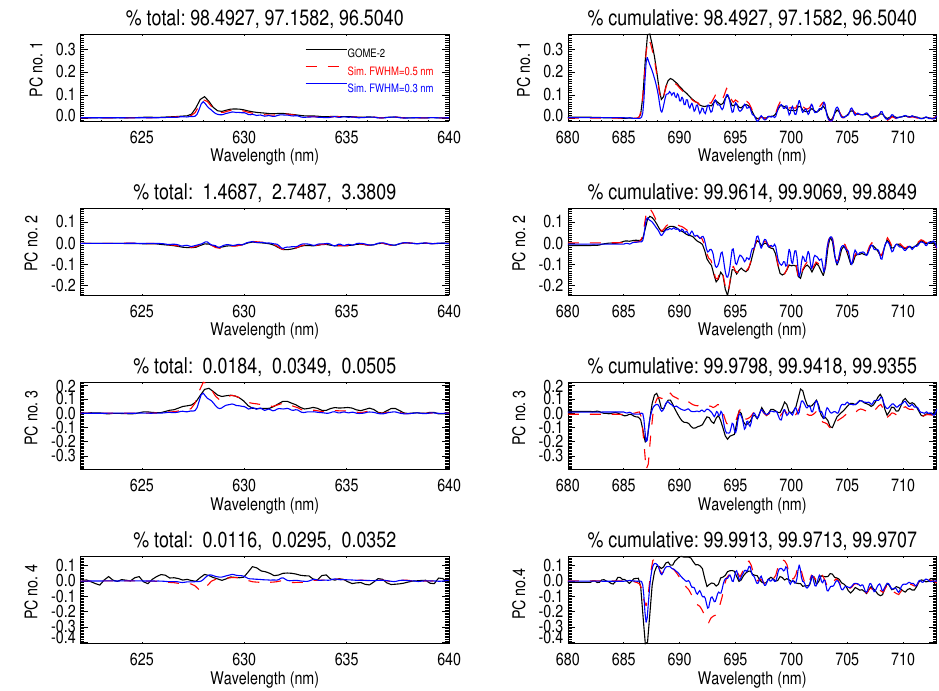
Figure 2. Leading principal components (PCs) of simulated (Sim.) and actual GOME-2 reflectance spectra (from 1 July 2012, black) for spectral windows encompassing the oxygen γ band (left panels) and B band (right panels). Simulated data are for a GOME-like instru- ment (red lines) with FWHM = 0.5nm (red) and a higher spectral resolution instrument with FWHM = 0.3nm (blue); numbers in the top titles are the variance explained in terms of percent of the total and cumulative percent of the total with numbers for GOME-2, simulated FWHM = 0.5nm, and FWHM = 0.3nm,